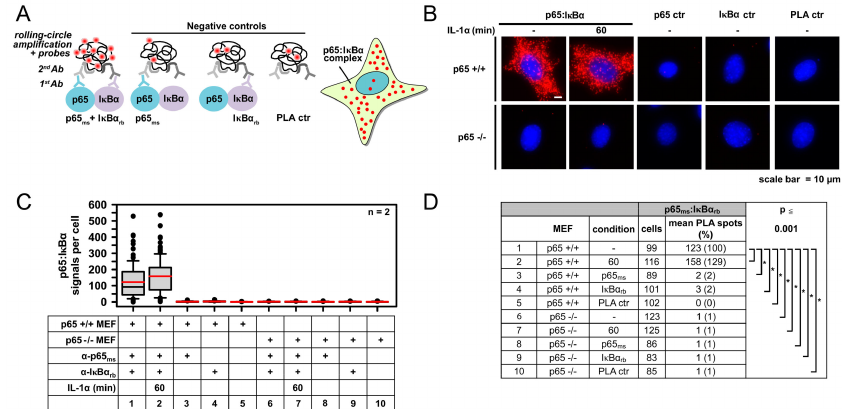
Figure 1. Specificity of proximity ligation assay- (PLA) based detection of p65 / I κ B α complexes as revealed by the analysis of IL-1 α -triggered wild type or p65-deficient mouse embryonic fibroblasts (MEFs). ( A ) Scheme of the PLAs used to determine p65 / I κ B α heterodimers including three types of negative controls that were used throughout this study to assess background signals. At the end of the PLA procedure, protein complexes were visualized as fluorescent spots by microscopic imaging and signals per cell were counted for quantification. ( B ) Wild type (p65 +/+ ) or p65-deficient MEFs (p65 − / − ) were left untreated or were stimulated with IL-1 α (10 ng / mL) for 60 min. Cells were fixed and analyzed by PLA by adding antibodies recognizing p65 (F-6) and I κ B α (E130). After the PLA reaction, the nuclei were stained with Hoechst 33342. Representative merged images are displayed. ( C ) PLA signals from individual stained cells were quantified using the Duolink ® ImageTool software. Box plots visualize the distribution of p65 / I κ B α complexes (PLA signals) per cell. Data from two independent experiments were pooled. ( D ) The table summarizes the numbers of analyzed cells, PLA signals per cell, relative changes and the significance of changes as obtained by the Mann–Whitney Rank Sum Test ( p ≤ 0.001).